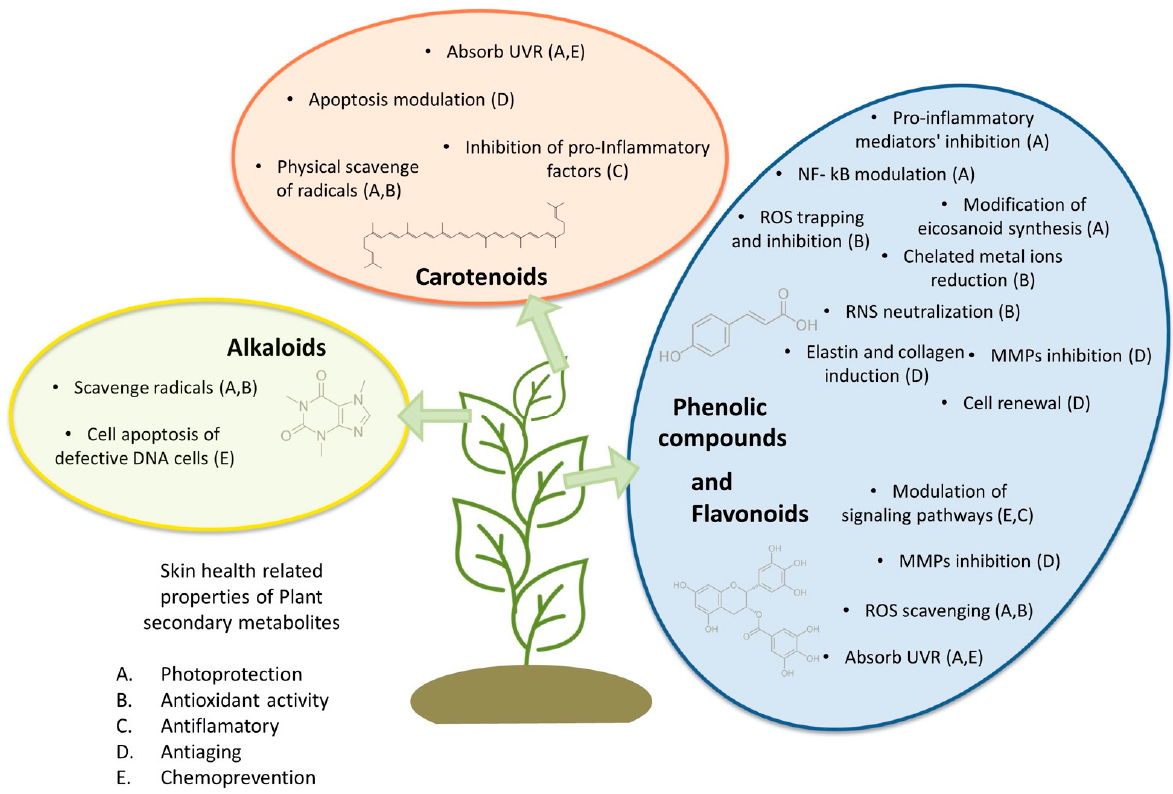
Figure 2. Plant secondary metabolites against skin photodamage. Mechanisms of action and skin- related bioactivities. Matrix metalloproteinases (MMPs) activation protein-1 (AP-1); Nuclear factor-kB (NF- κ B), ultraviolet radiation (UVR); reactive oxygen species (ROS), reactive nitrogen species (RNS).